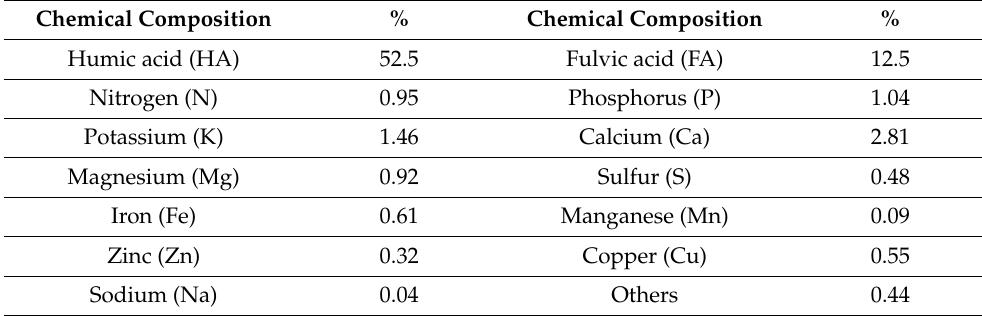
Table 3. The chemical composition of applied humic substances in the